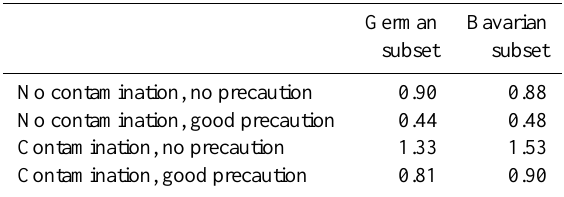
Table 3. Derived scaling factors for building losses due to private precaution and contamination. Factors for the extended loss model FLEMO AT+ are differentiated between the two subsets from Ger- many and